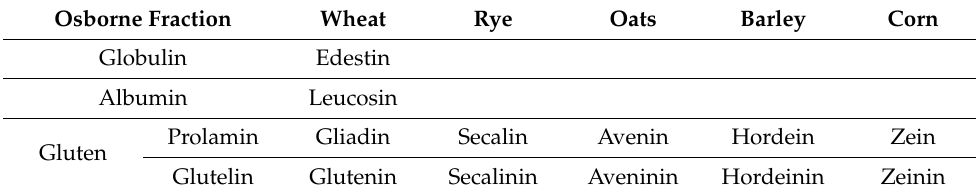
Table 1. Protein fractions from cereal grains